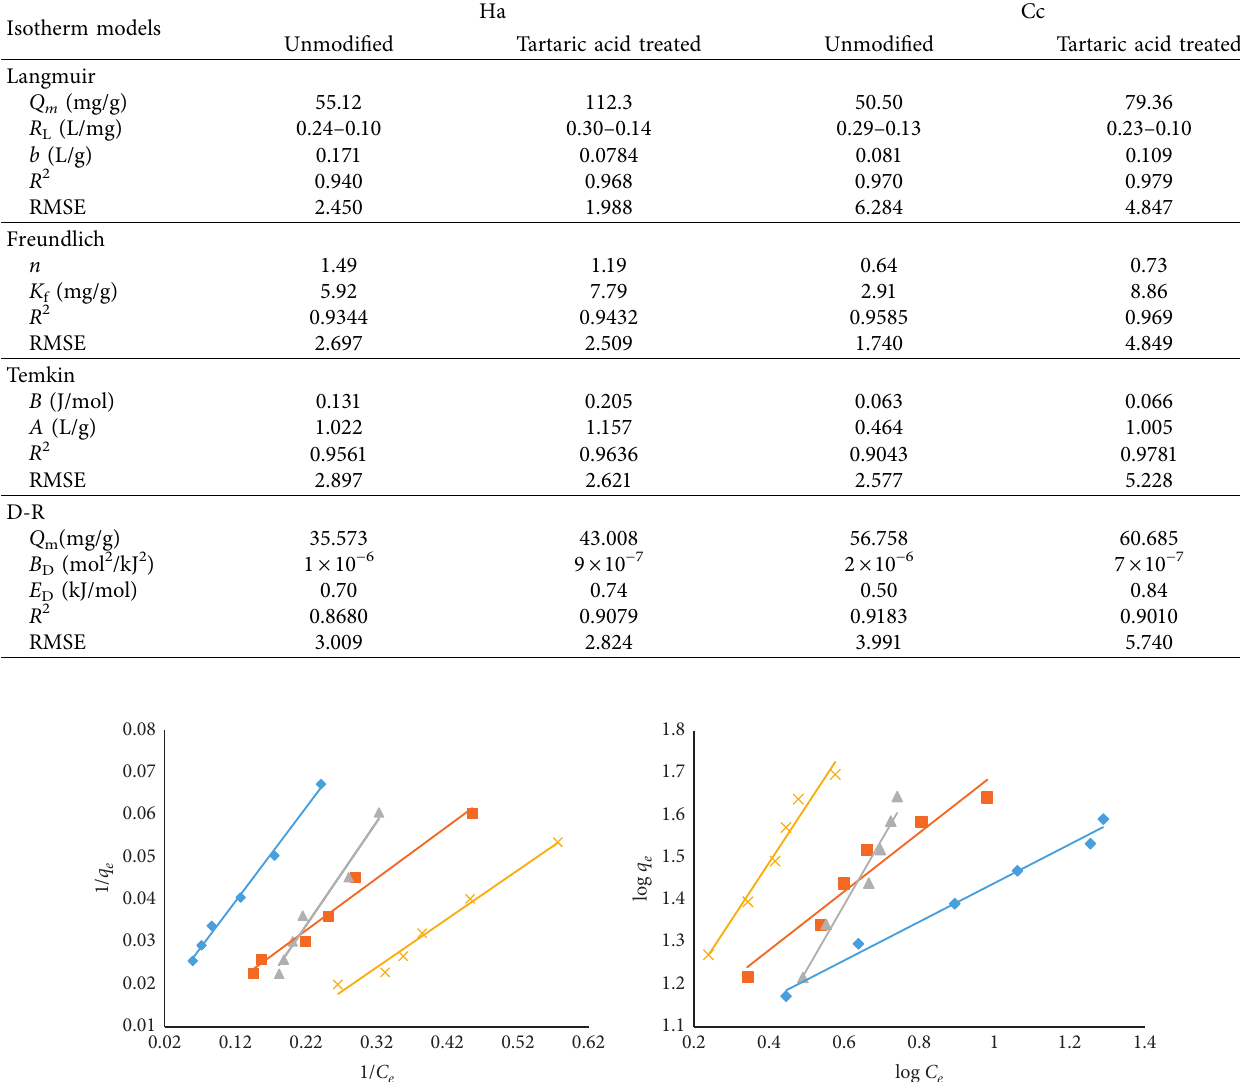
Table 1: Isothermal parameters for BG dye adsorption.